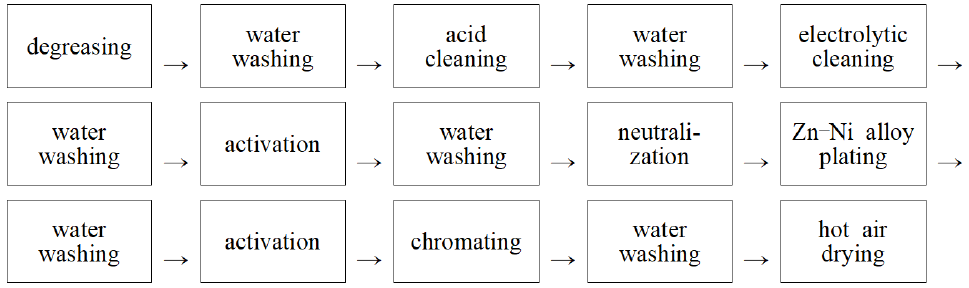
Figure 1. Process diagram of Zn–Ni alloy plating surface treatment.